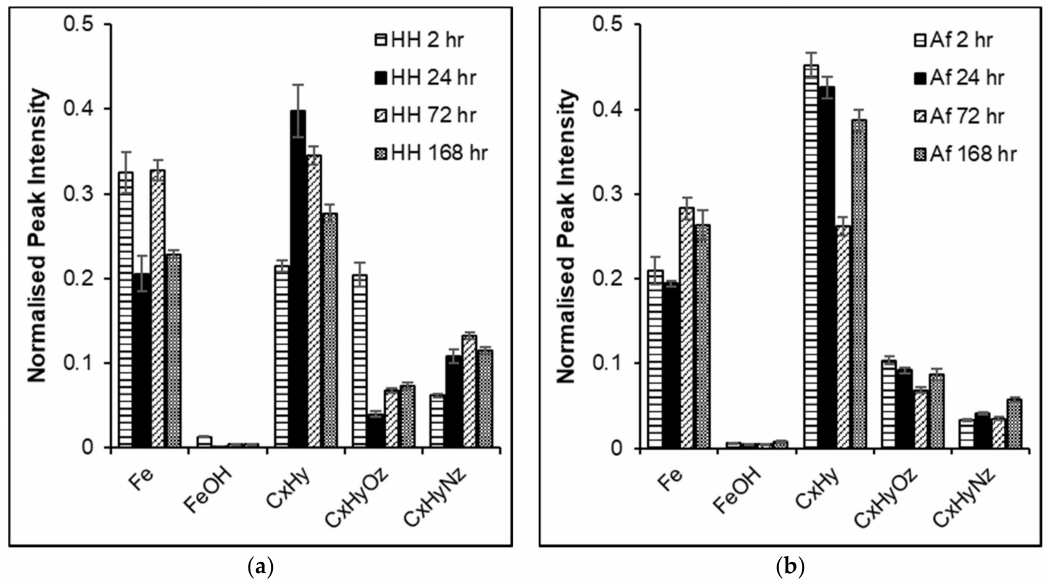
Figure 6. ToF-SIMS normalised peak intensities of positive ion fragments of pyrite exposed to: ( a ) HH medium for 2, 24, 72 and 168 h; and ( b ) A. ferrooxidans for 2, 24, 72 and 168 h. 95% confidence interval where n =